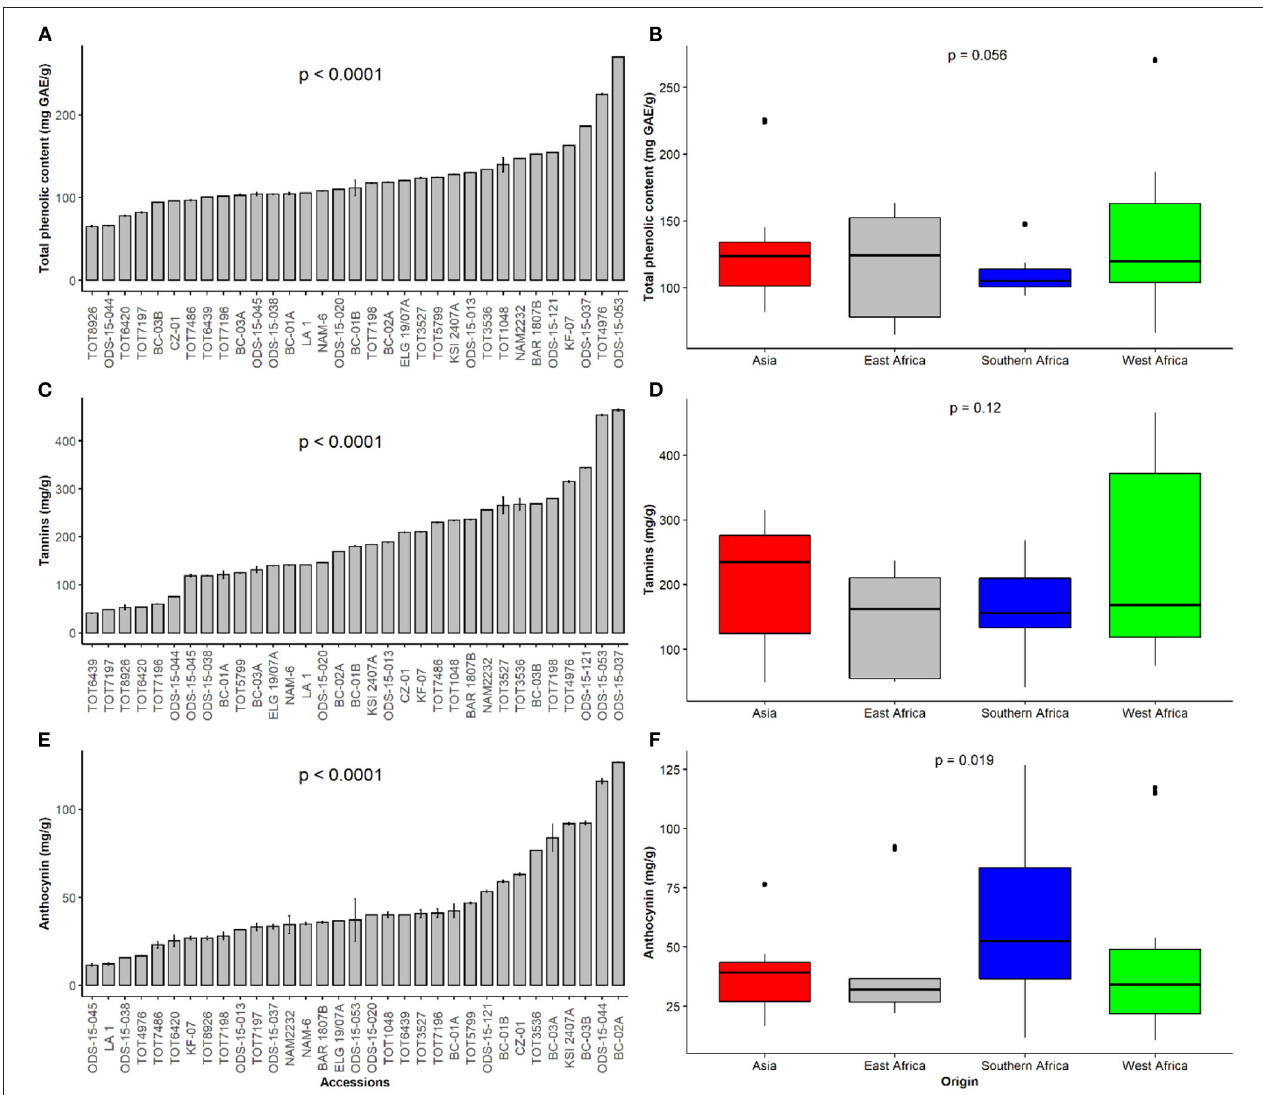
FIGURE 2 | Dietary phytochemical content of a collection of 33 Gynandropsis gynandra accessions and based on the regions of origin. (A) Total phenolic content among 33 accessions of spider plant. (B) Total phenolic content among accessions of spider plant based on their regions of origin. (C) Tannin content among 33 accessions of spider plant. (D) Tannin content among accessions of spider plant based on their regions of origin. (E) Anthocyanin content among 33 accessions of spider plant. (F) Anthocyanin content among accessions of spider plant based on their regions of origin.